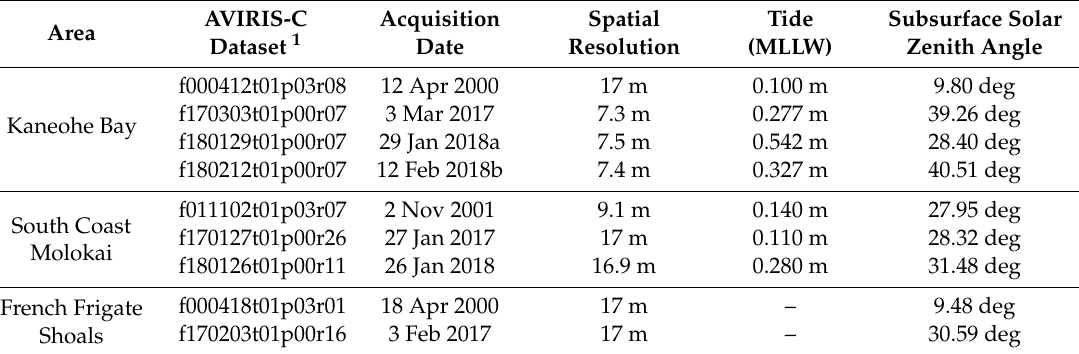
Table 1. Airborne hyperspectral data from NASA’s Classic Airborne Visible / Infrared Imaging Spectrometer (AVIRIS-C) used in semi-analytical inversion modeling